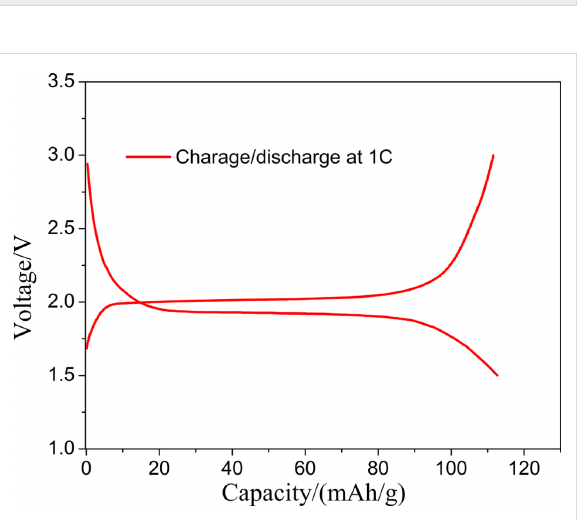
Figure 12: Charge–discharge curves of the LiFePO 4 //Li 4 Ti 5 O 12 all- fiber battery at